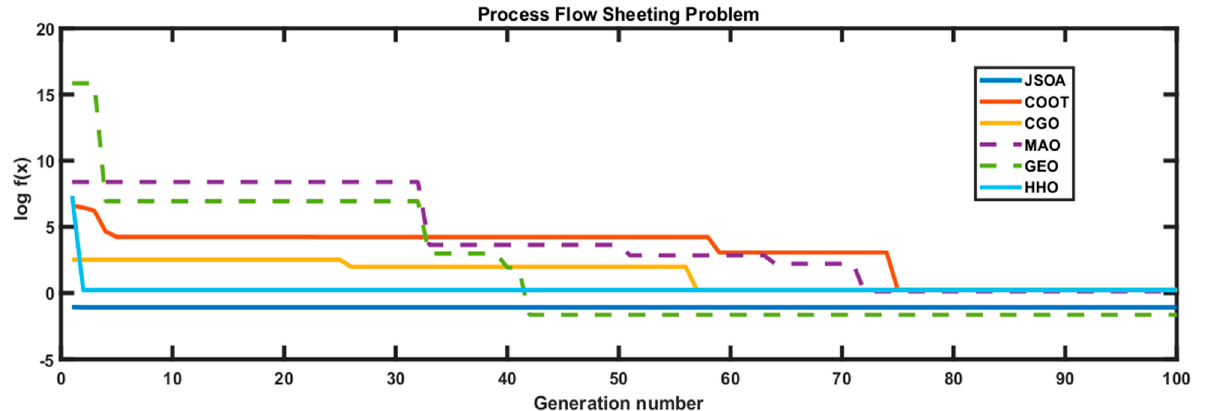
Figure 11. Convergence graph of the Process Flow Sheeting Problem. The dotted line represents an infeasible solution shown by an algorithm.